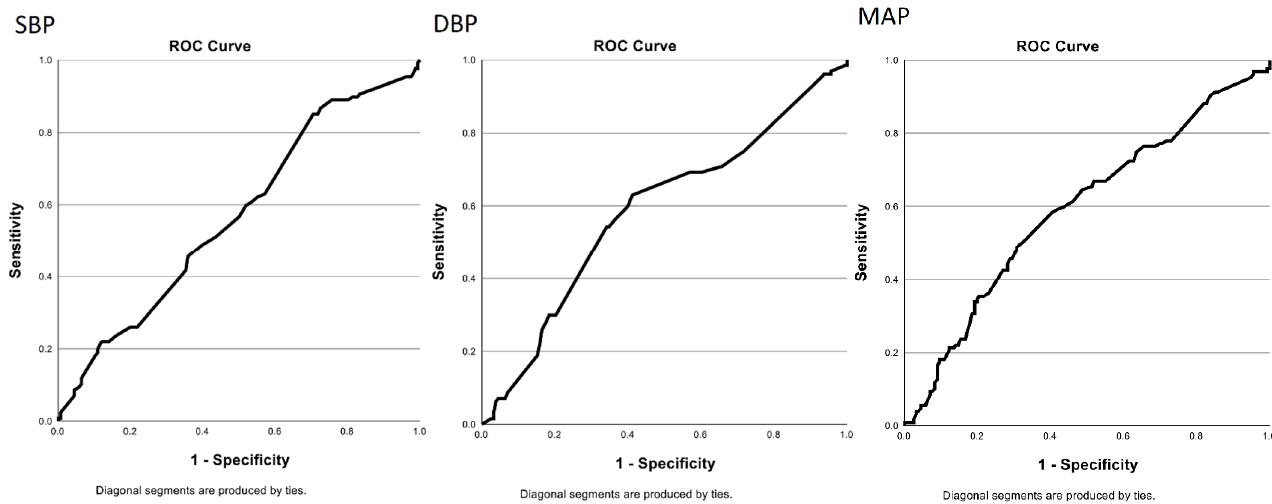
Figure 1. Univariate logistic regression. Maximum values of sum of sensitivity and specificity in ROC analysis. Table 3. Linear regression model.